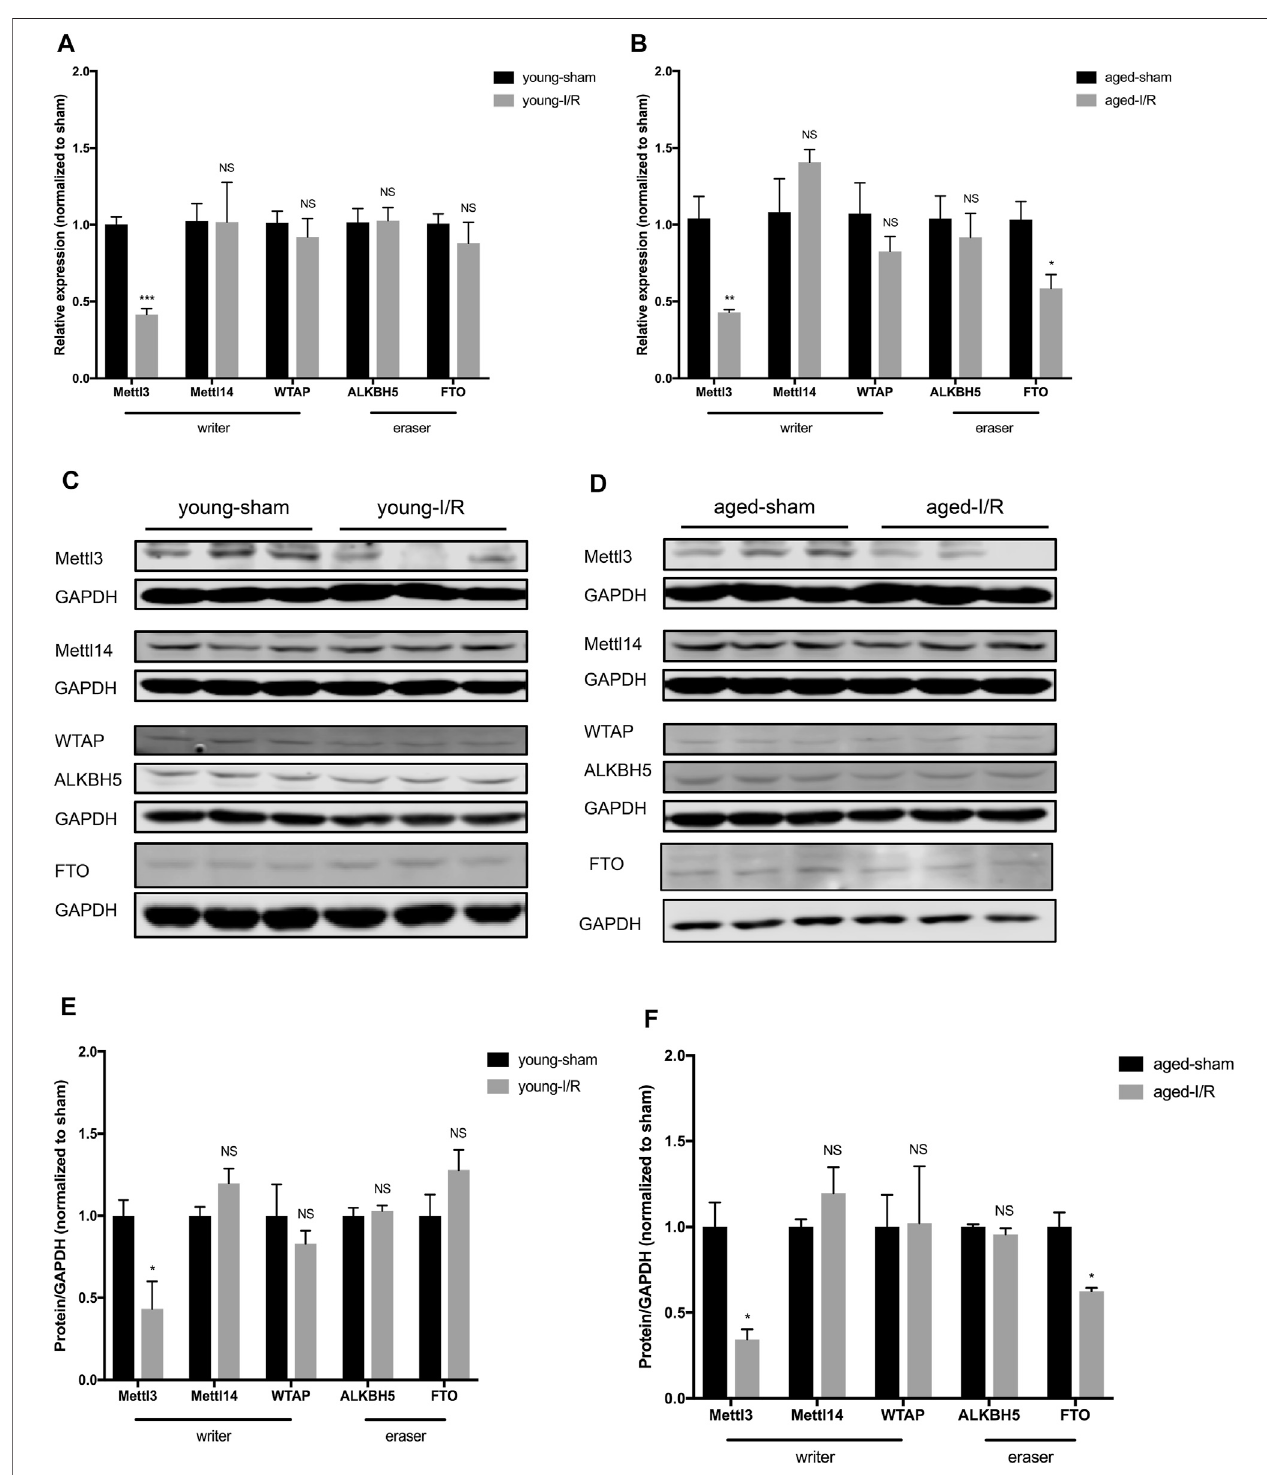
FIGURE 4 | Age-related differences in the expression of m6A RNA methylases and demethylases in response to acute myocardial I/R injury. (A) . Quanti fi cation of mRNAlevelofm6ARNAmethylasesanddemethylasesinyoungmice,n (cid:1) 4to5. (B) .Quanti fi cationofmRNAform6ARNAmethylasesanddemethylasesinagedmice, n (cid:1) 4 to 5. (C) . Representative immunoblots for m6A RNA methylases and demethylases in young mice undergoing sham and I/R injury. (D) . Representative immunoblots for m6A methylases and demethylases in aged mice undergoing sham and I/R injury. (E) . Densitometry quanti fi cation of protein for m6A RNA methylases and demethylases in young mice, n (cid:1) 3. (F) . Densitometry quanti fi cation of protein for m6A methylases and demethylases in aged mice, n (cid:1) 3. Results are presented as mean ± standard error of the mean (SEM). NS, p > 0.05; * p < 0.05; ** p < 0.01; *** p < 0.001.